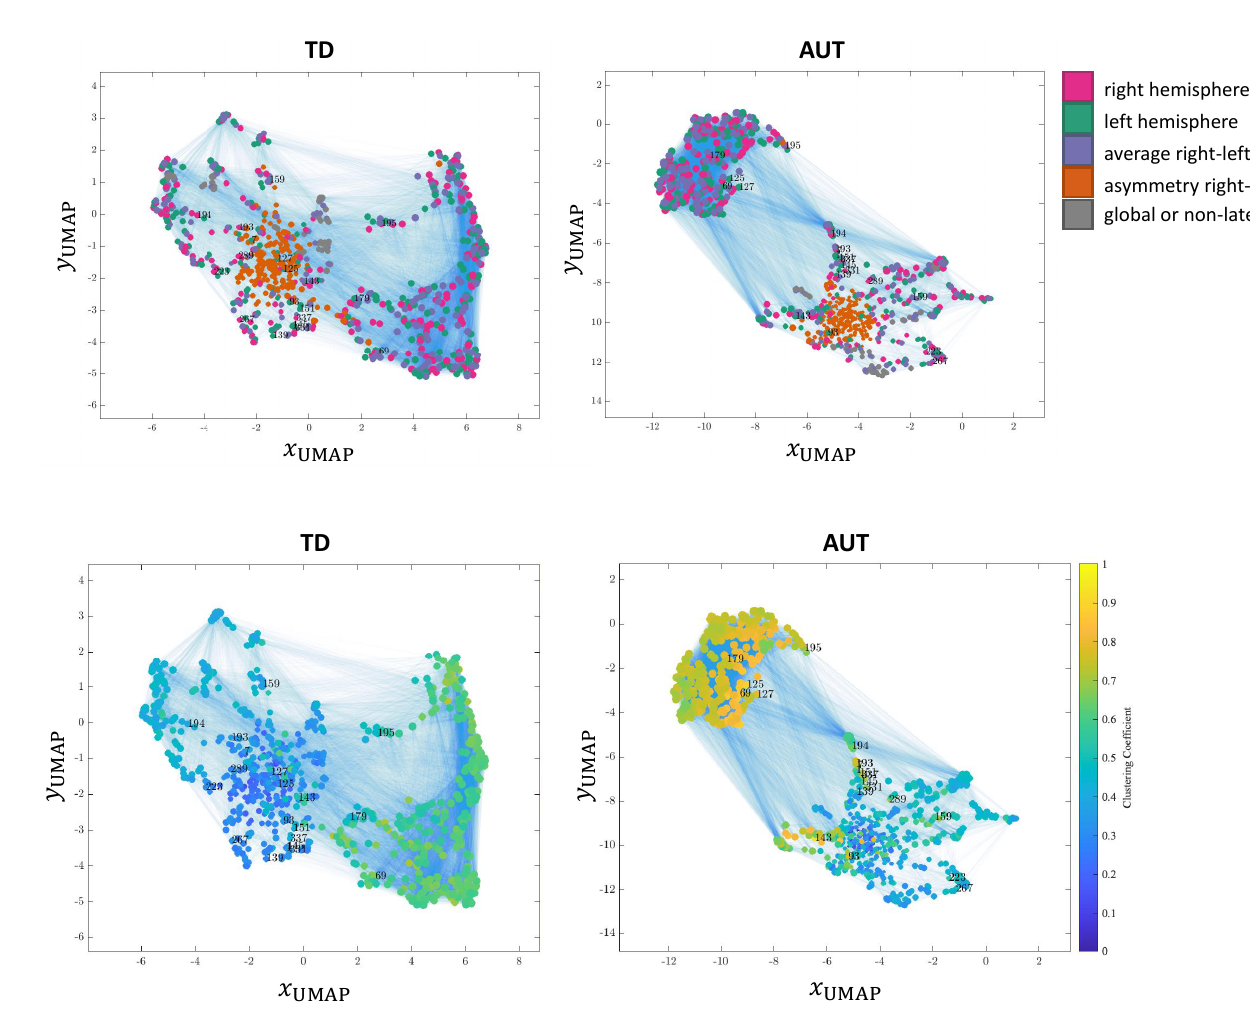
Figure 5. Representation of TD and AUT weighted networks with UMAP layout. Top : nodes colored by feature laterality. Features refer to the right or left hemisphere, to the average or to the difference (asymmetry) between corresponding left-right features, or global features referring to the whole brain. Bottom : nodes colored by clustering coefficient values. We annotate the number IDs of the top-20 features with the largest variation in clustering